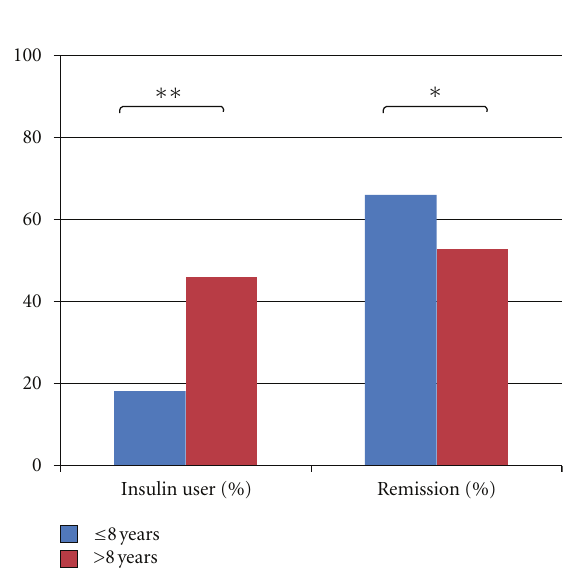
Figure 1: Clinical outcomes of diabetes according to duration of T2DM prior to surgery. ∗∗ P < 0 . 01, ∗ P < 0 .